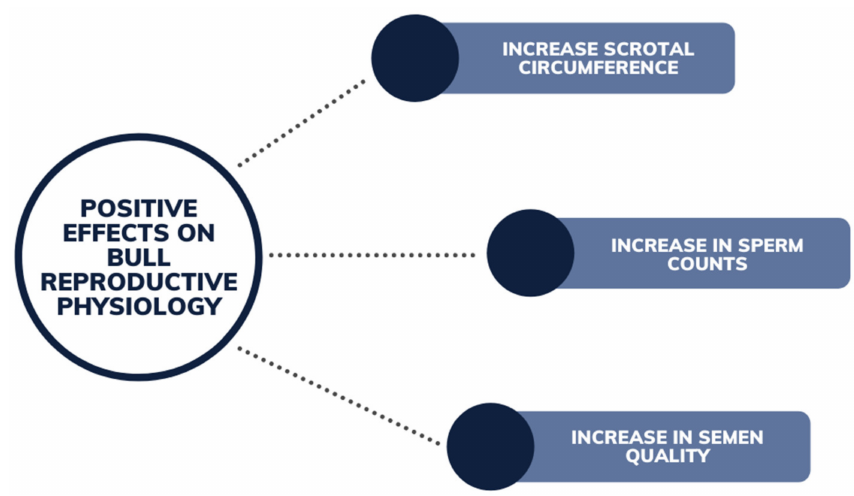
Figure 8. Beneficial effects of phytoestrogens on bull reproductive physiology from grazing legume pastures.